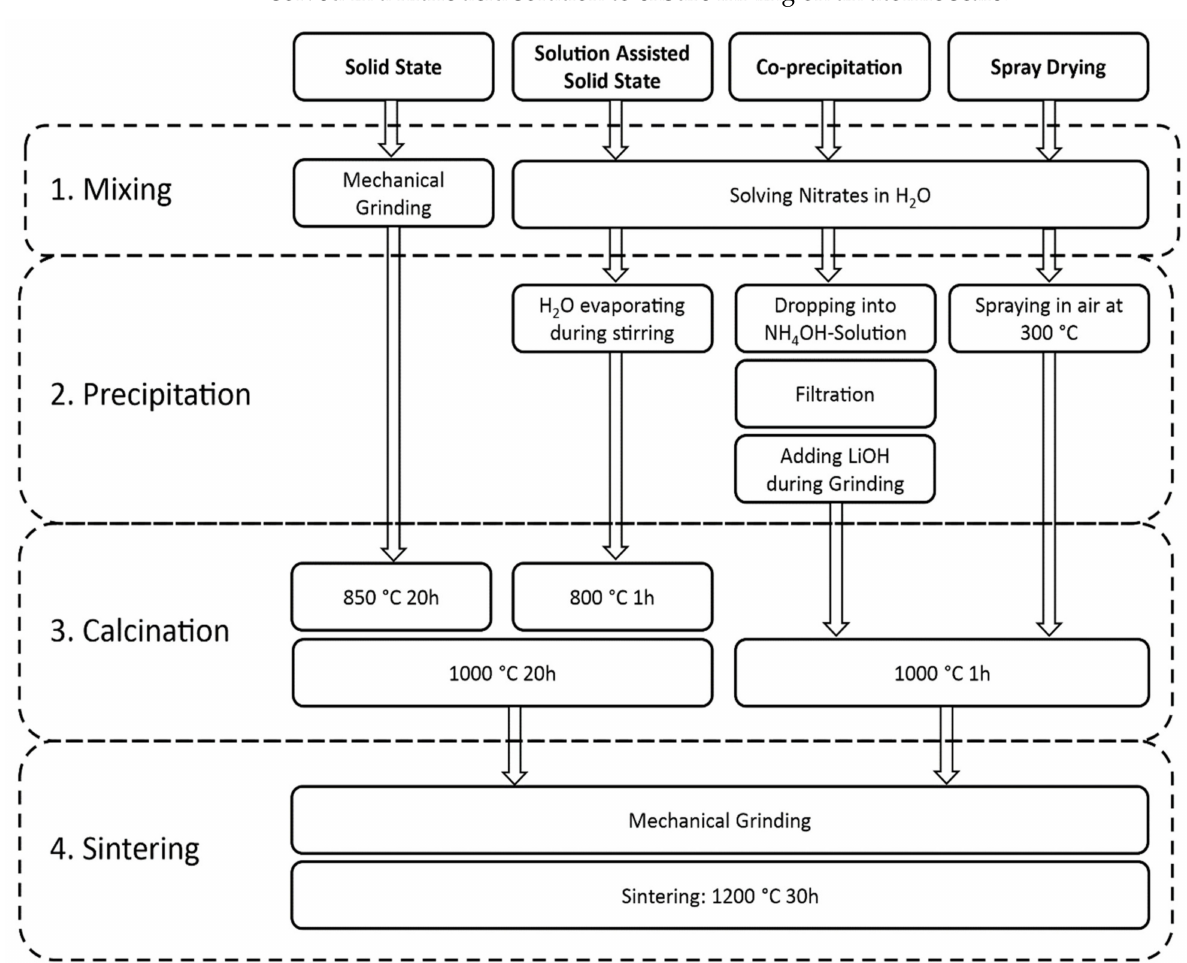
Figure 1. Flowchart showing the major synthesis steps of the four different synthesis methods: solid-state reaction (SSR), solution-assisted solid-state reaction (SASSR), co-precipitation (CP), and spray-drying